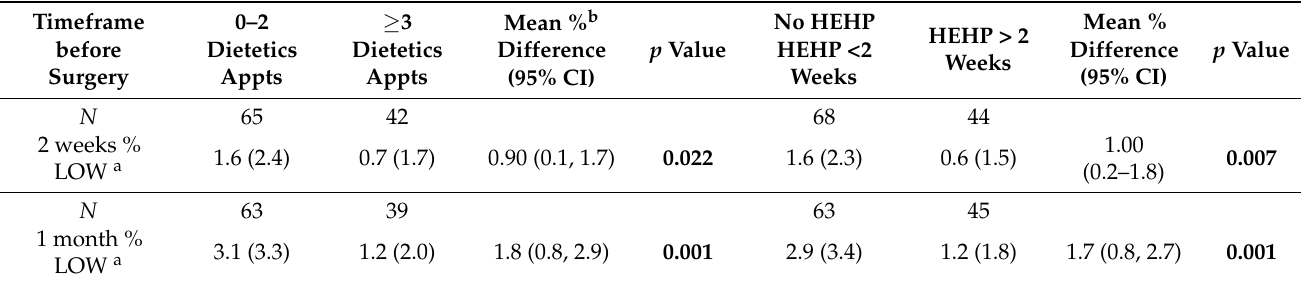
Table 5. Associations between preoperative dietetics intervention and HEHP supplements with preoperative weight loss 2 weeks and 1 month before